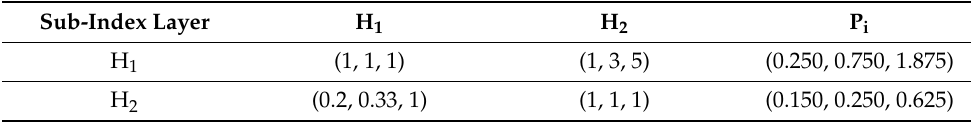
Table 5. Hazard layer weights determined by TFN-AHP.